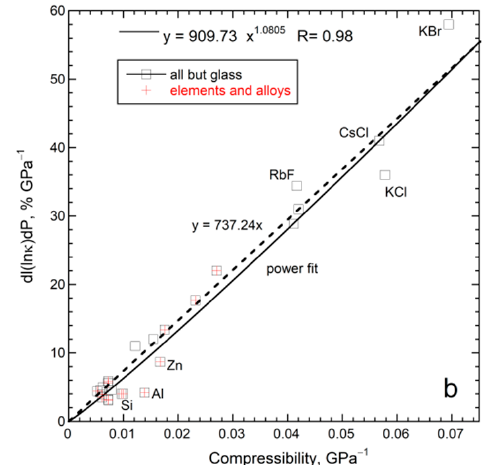
Figure 14. Graphical representation of data compiled in Table 3. Metals and Si (red crosses) are included in the fits: ( a ) Comparison of values from Equation (24) to measurements of κ as a function of pressure. RbF was excluded due to uncertainites in c P [68]; ( b ) Dependence of ∂ ln( κ )/ ∂ P on compressibility ( B T − 1 ), excluding fused quartz where bonds bend rather than contract. In both panels, hard solids cluster. These involve small, difficult to measure, changes during compression. Soft halides have large changes, but deform and absorb water, producing systematic errors. Halides with B T < 15.5 GPa, which is accompanied by ∂ ln κ / ∂ P > 60% GPa − 1 and phase transformations at very low P , were excluded from these plots.